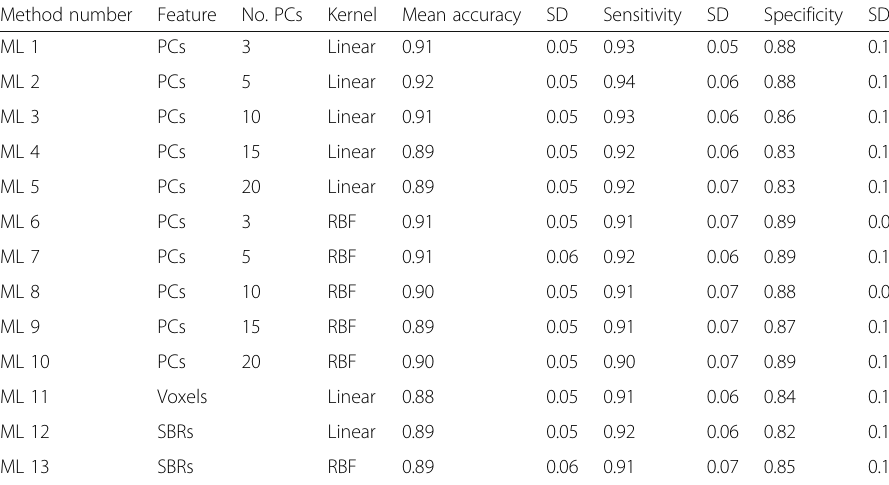
Table 6 Machine learning results for local clinical